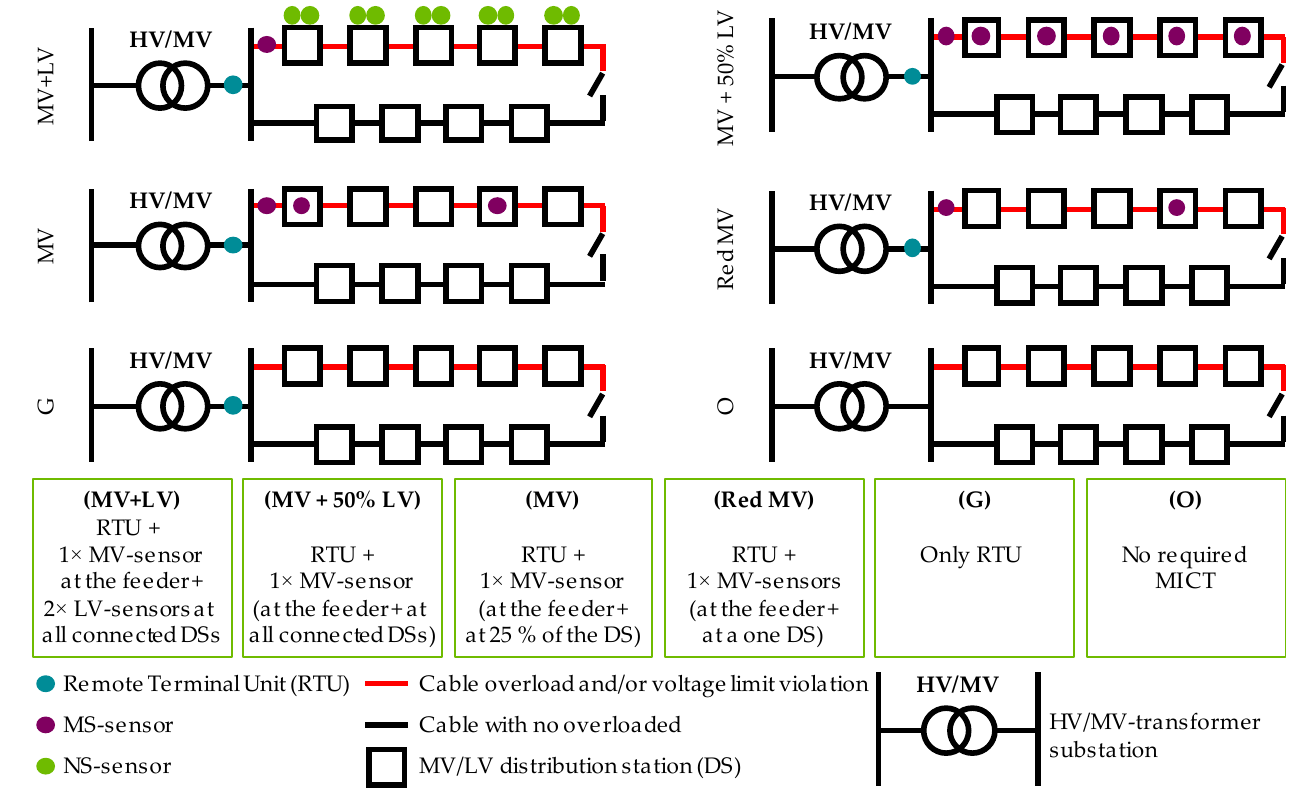
Figure 6. Illustration of the six load management layouts for one medium voltage ring based on [59].